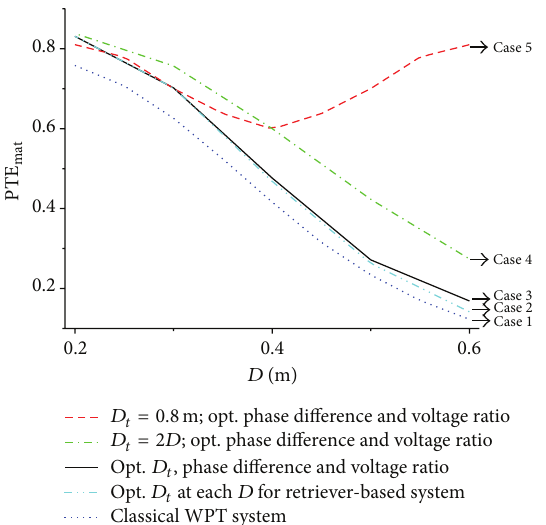
Figure 20: Efficiency of the considered WPT systems. Five different systems are considered: case 1 : classical WPT system (single source; optimum frequency for maximum efficiency); case 2 : retriever- based system (single source; optimum frequency and 𝐷 𝑡 for maximum efficiency); case 3 : WPT system with two transmitters based on the optimum 𝐷 𝑡 of retriever-based system (two sources; optimum frequency, distance 𝐷 𝑡 , phase difference and voltage ratio for maximum efficiency); case 4 : 𝐷 𝑡 = 2𝐷 (two sources; optimum frequency, phase 2 − phase 1 = 0 and 𝑉 2 /𝑉 1 = 1 for maximum efficiency); case 5 : 𝐷 𝑡 = 0.8 m (two sources; optimum frequency, phase difference, and voltage ratio for maximum efficiency).